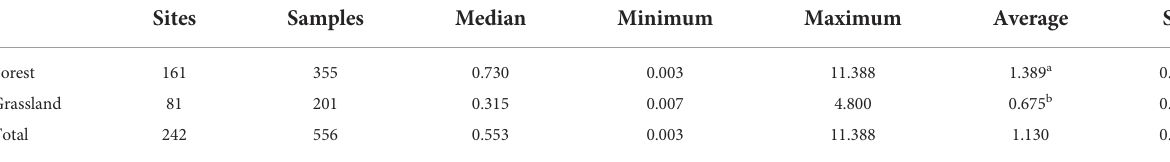
Sites Samples Median